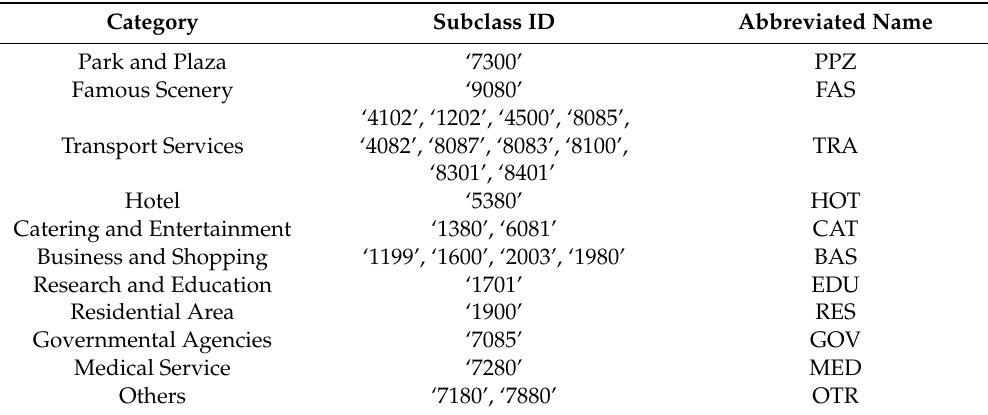
Table 1. Reclassification of POIs.